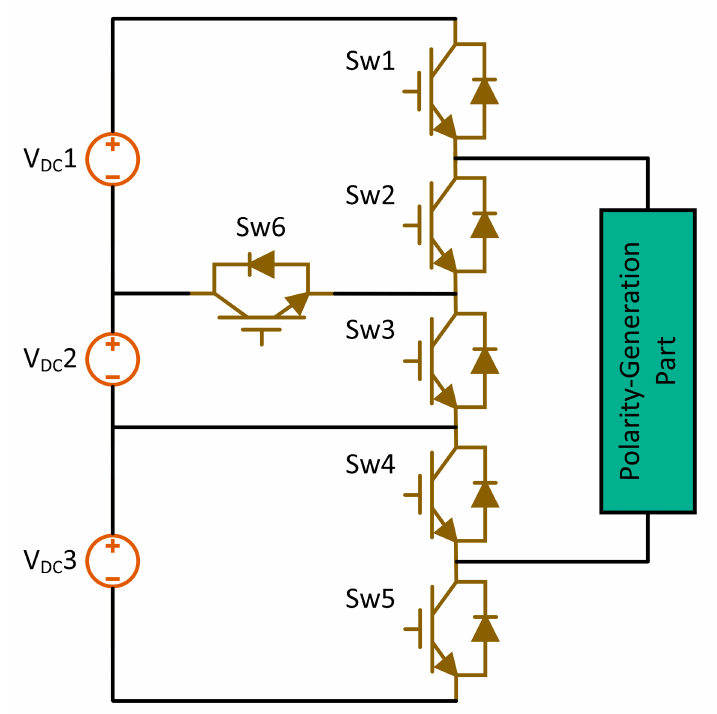
Figure 16. Topology of reversing voltage multilevel inverter.